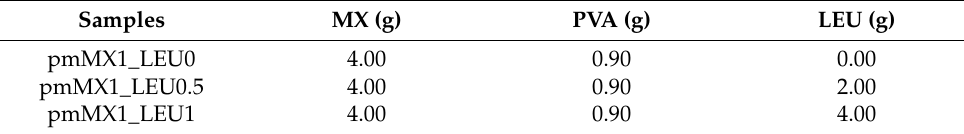
Table 2. Composition of the physical